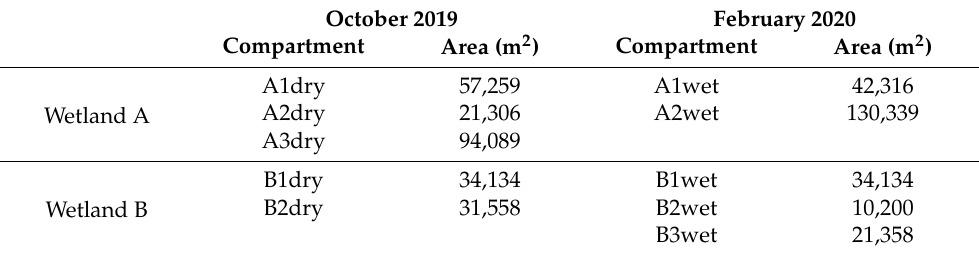
Table 2. Wetland A and B photogrammetric calculations performed.